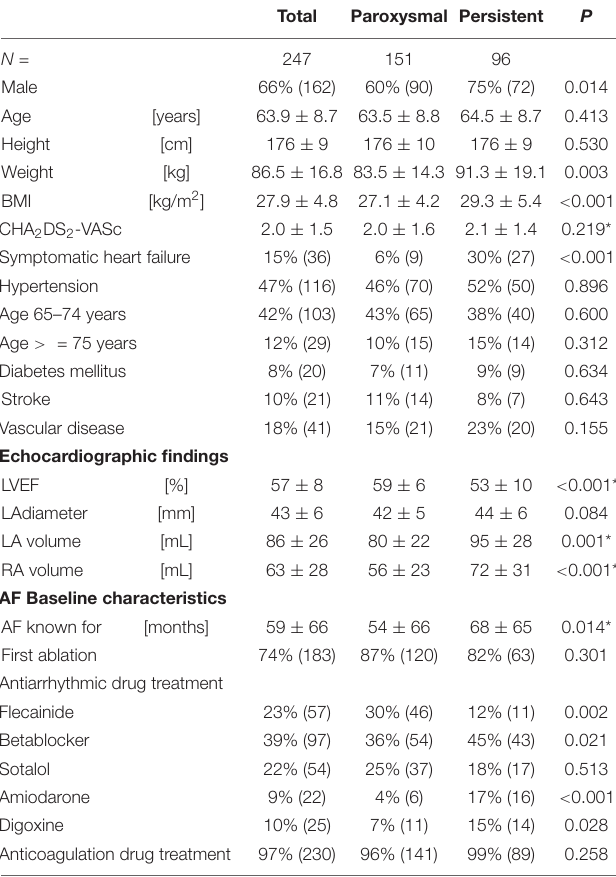
TABLE 1 | Baseline characteristics.